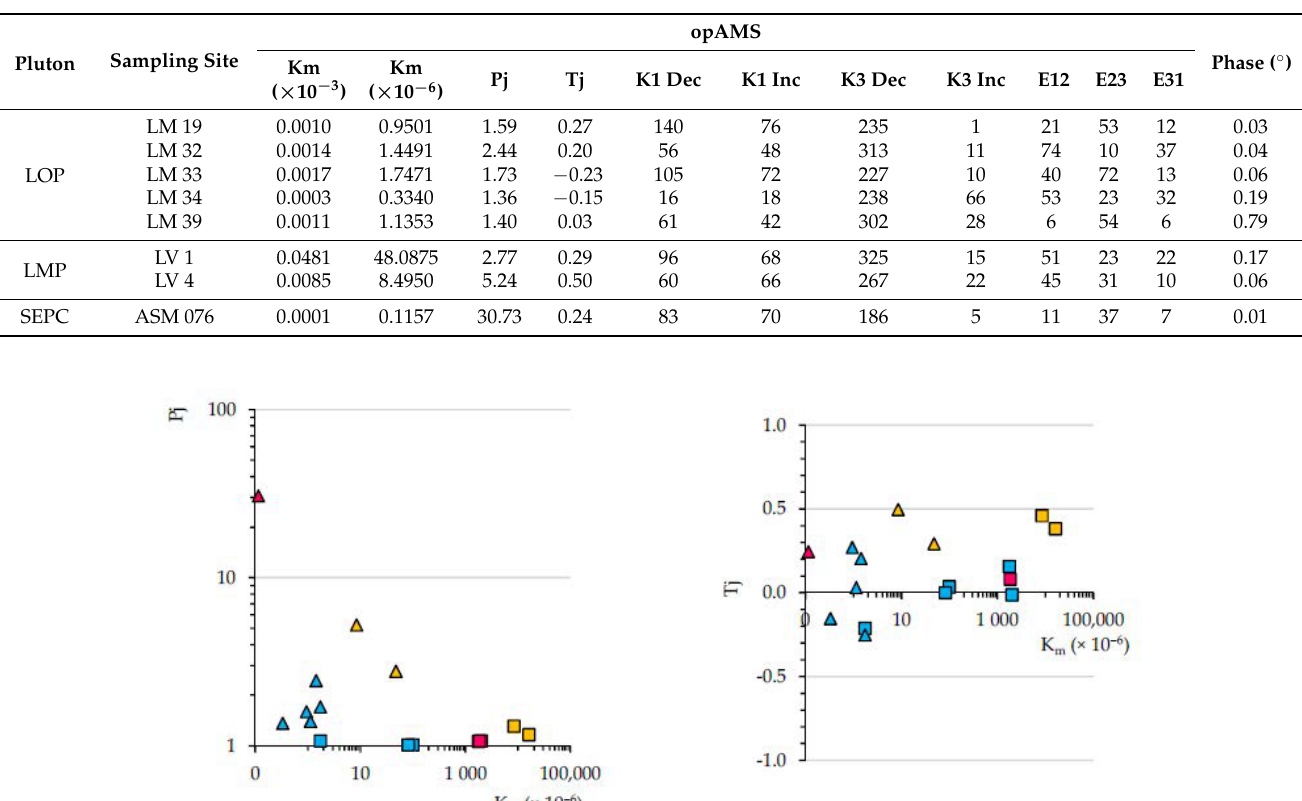
Table 2. opAMS data for studied granites and phase angle (the opAMS measurements were per- formed according to a specimen coordinate system).